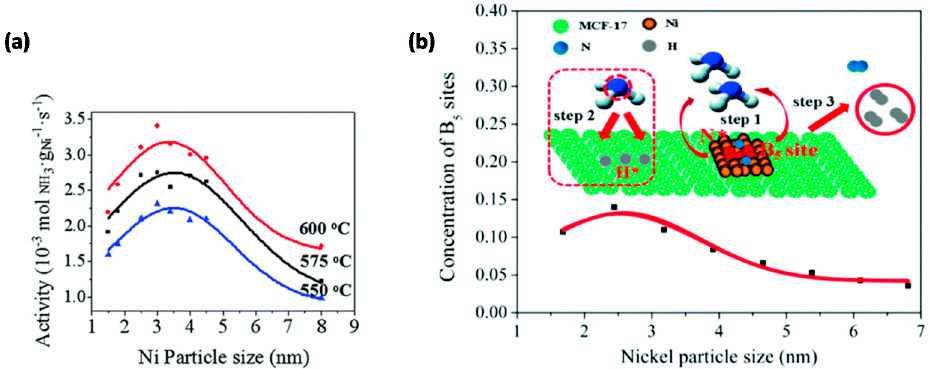
Figure 3. ( a ) NH 3 decomposition activity of Ni / MCF-17, normalized to the Ni loading, for various reaction temperatures as a function of the average Ni NP size. Reaction conditions: P = 1 bar, pure NH 3 , GHSV = 6000 mL g cat − 1 h − 1 . ( b ) The concentration of active B 5 sites as a function of the average Ni NP size, with NH 3 decomposition reaction mechanism on B 5 sites of Ni catalysts. Step 1: NH 3 chemisorption; step 2: consecutive dehydrogenation of NH 3 ; step 3: associative desorption of H* and N* to form H 2 , respectively, N 2 . N* and H* denote adsorbed N and H atoms. Reproduced